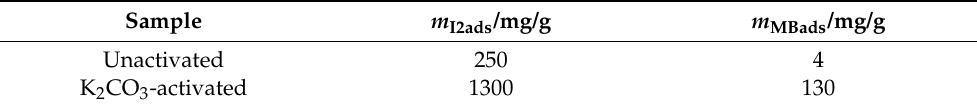
Table 1. Amount of adsorbed I 2 ( m I2ads ) and amount of adsorbed methylene blue ( m MBads ).